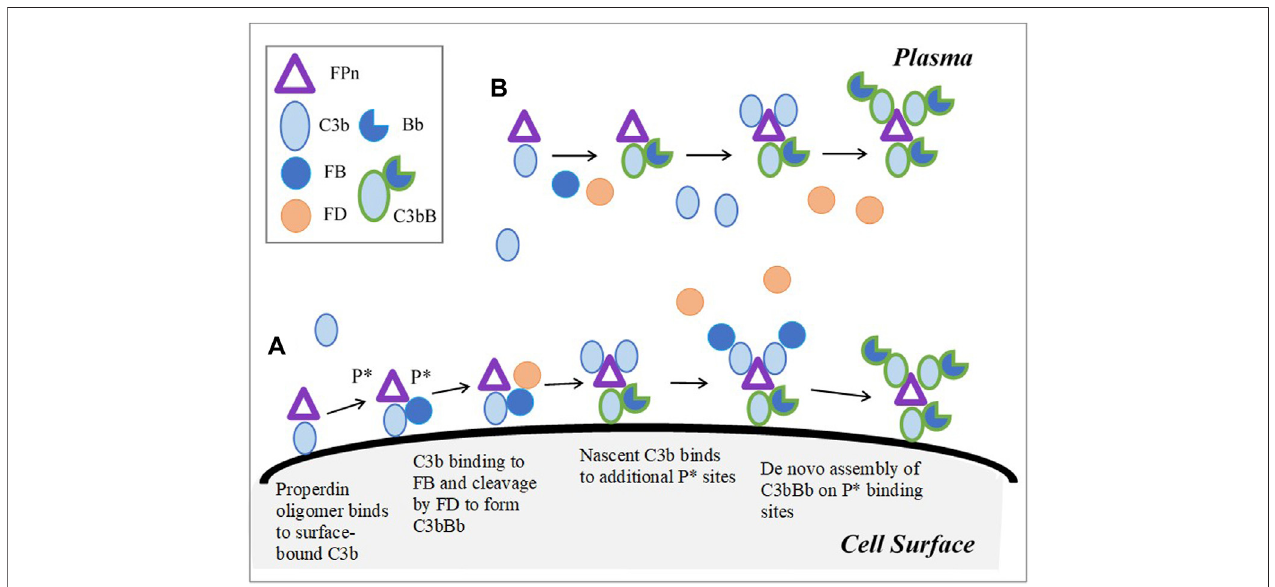
FIGURE2| ModelimplementationforProperdindynamicsinplasmaandcellsurface(expandedbasedonFigure6inHourcade(2006)). (A) Cellsurface:Properdin binds to surface bound C3b and C3-proconvertases, C- convertase, or iC3b, and provides two additional sites P* for the de novo assembly of the convertase. FPn bindingtoonlysurface-boundC3bisshown inthe fi gureforsimplicity.Similarly,inaddition toC3b-P*binding,C3proconvertase – C3bB, C3b-convertase, andiC3bcan occupyP*sites. (B) Plasma:C3boritscomplexesandcleavageproductsbindtothreebindingsitesonFPn,leadingtoconvertaseassembly.Unlikeoncellsurface, P* does not contribute to ampli fi cation of the pathway through additional binding sites in plasma; however, complement activation in plasma is enhanced by Properdin due to increased binding between C3bP and FB, and stabilization of